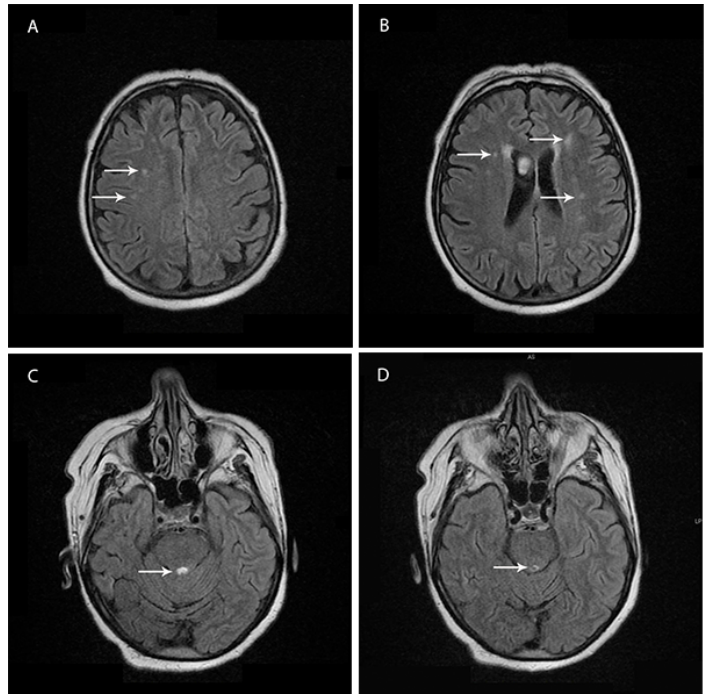
Figure 1. ( A – D ) Brain magnetic resonance imaging (MRI) study on T2-fluid attenuation-recovery (FLAIR). ( A , B ) Bilateral supratentorial subcortical increased signal intensities on FLAIR images. ( C , D ) Periaqueductal grey matter hyperintensity in FLAIR images.